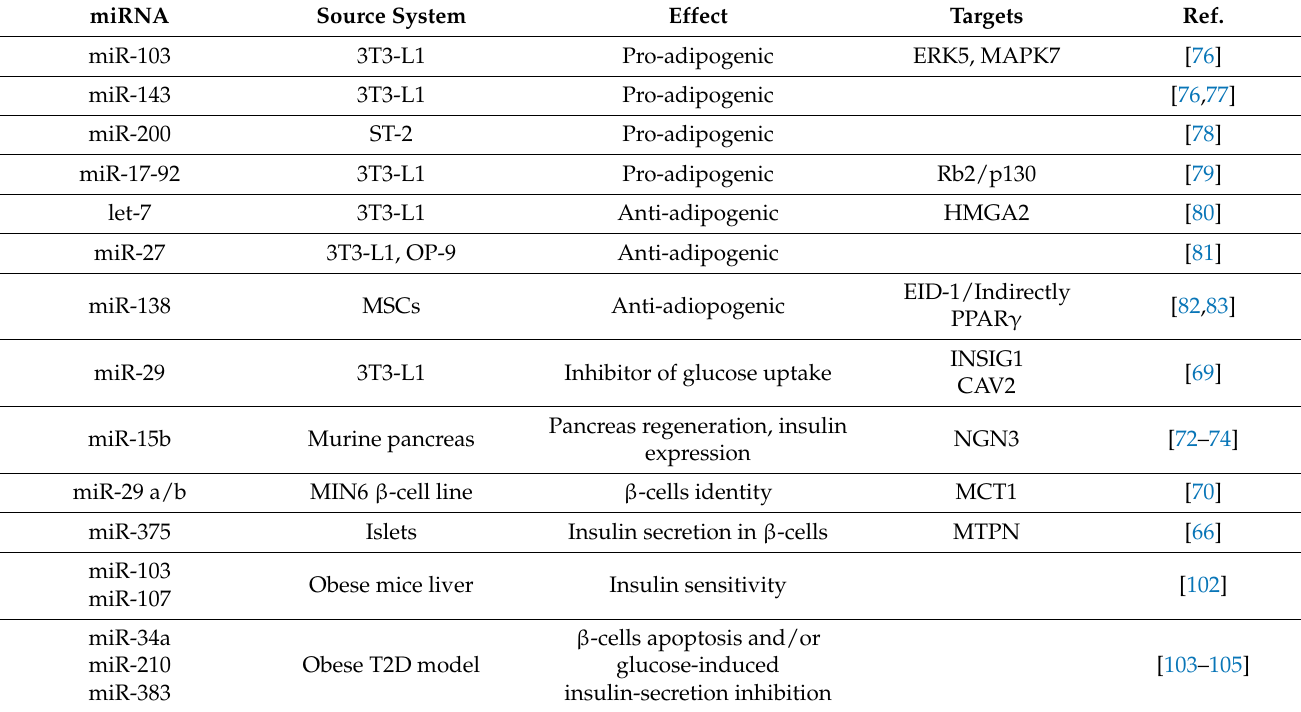
Table 1. Mammalian miRNAs regulating adipogenesis and insulin sensitivity.